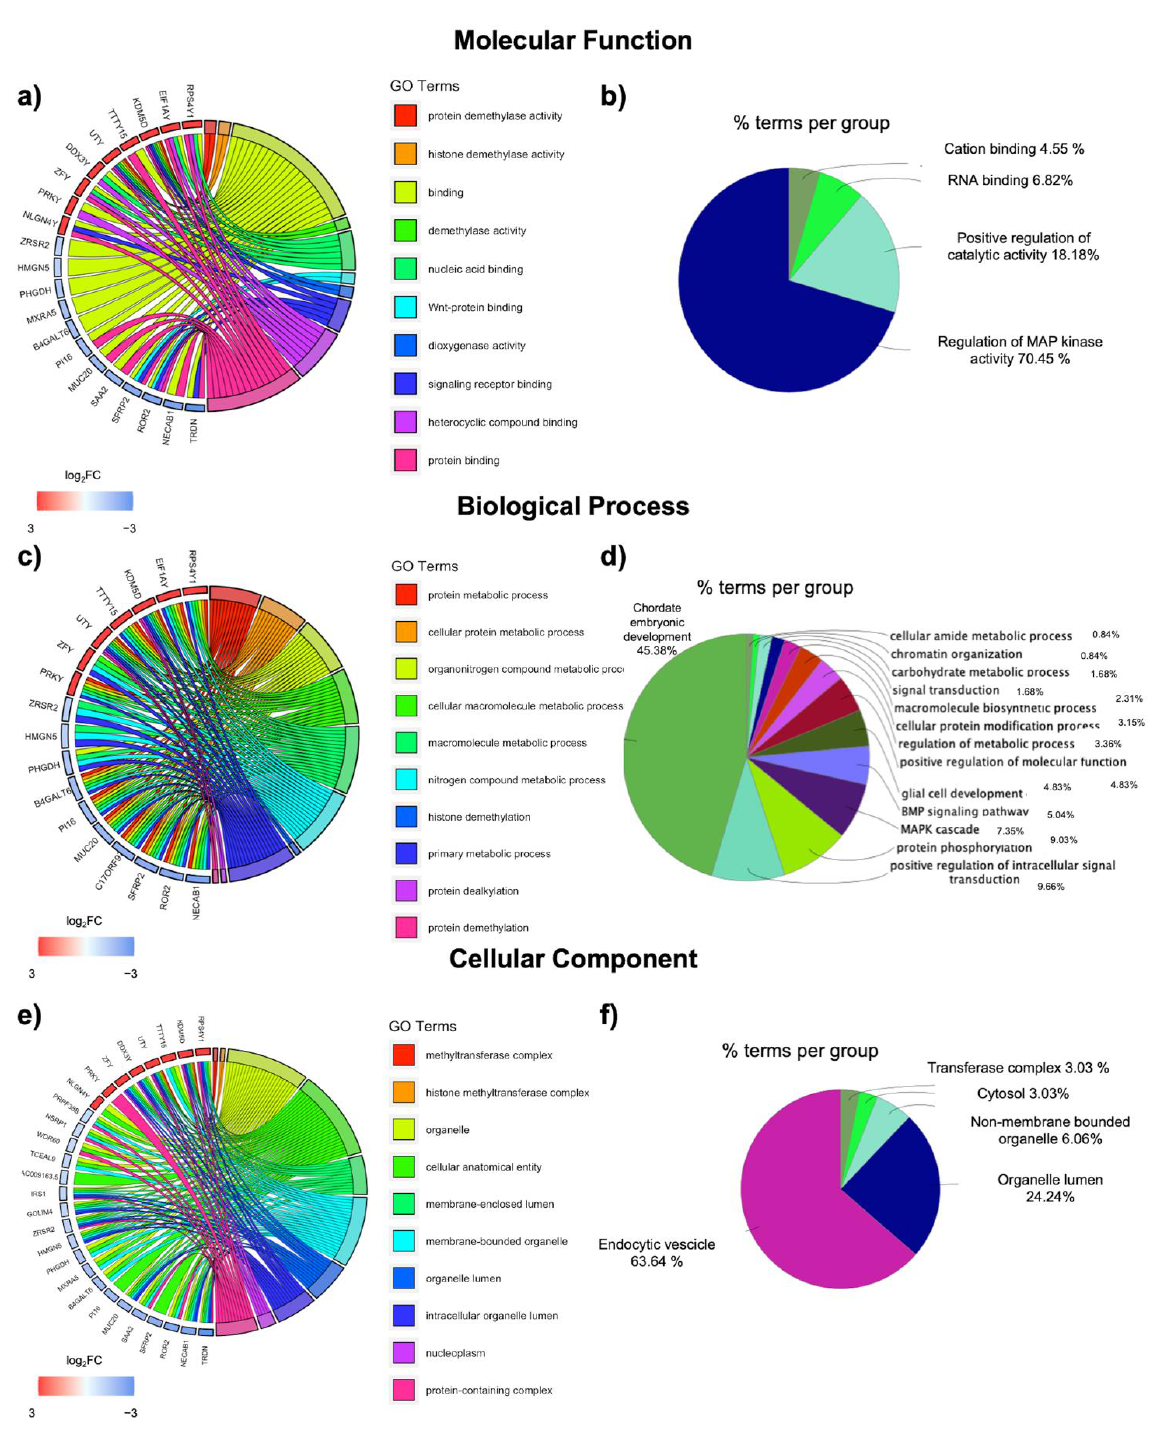
Figure 2. Gene Ontology in obese men vs. women. Gene ontology was performed for molecular function and displayed as a GO Chord ( a ) or a ClueGO Graph ( b ), for biological processes it is displayed as a GO Chord ( c ) or a ClueGO Graph ( d ), and for cellular component it is displayed as a GO Chord ( e ) or a ClueGO Graph ( f ). For the GO Chord graphs, on the right, are shown the top 10 significant GO terms for the cellular component, whereas on the left the corresponding genes are ordered according to log 2 FC. Segments connect each term to the respective involved gene. For the ClueGO graphs, each pie segment refers to the % of terms present per